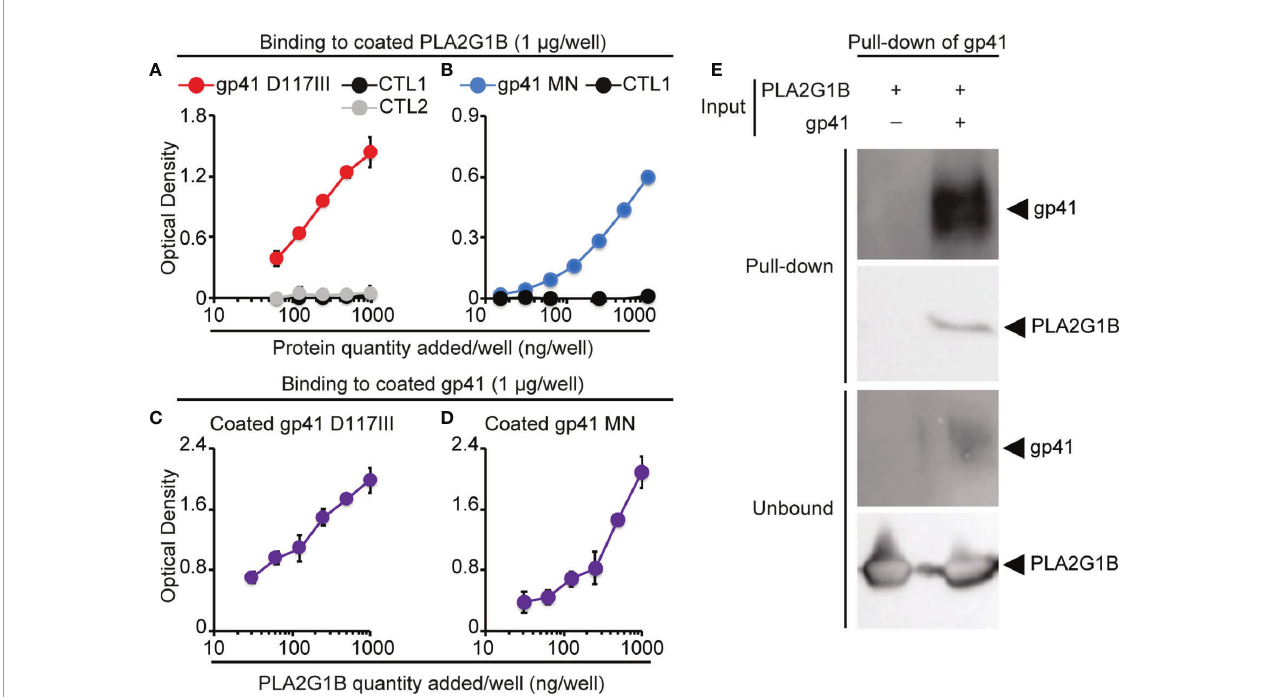
FIGURE 2 | PLA2G1B directly binds to gp41. (A, B) gp41 binds to coated PLA2G1B by ELISA. Binding to coated PLA2G1B of serial dilutions (0-1 µg/well) of gp41 (D117III strain on A and MN strain on B), or unrelated proteins (CTL1: EFF-1 on A and B or CTL2: IF38 on A). (C, D) PLA2G1B binds to coated gp41 by ELISA. Binding of serial dilutions (0-1 µg/well) of PLA2G1B to coated gp41 (D117III on C, or MN on D) was tested in triplicate by ELISA. Results are shown as the mean ± SD of the OD value of one representative experiment among two (A) , fi ve (B) , one (C) and fi ve (D) . (E) gp41 binds to PLA2G1B in pull-down assays. Recombinant PLA2G1B protein was incubated with strep-tagged-gp41 (D117III strain, gp41+PLA2G1B) or not (PLA2G1B only). PLA2G1B-gp41 complexes were pulled-down with strep-tactin XT-beads that pull-down gp41. Pulled-down products and unbound proteins were revealed by immunoblotting with goat polyclonal anti-gp41 Ab or mouse anti-PLA2G1B mAb. One representative experiment of fi ve experiments with similar results with D117III gp41 is presented. Similar results were obtained in three experiments with MN gp41 ( Supplementary Figure 2